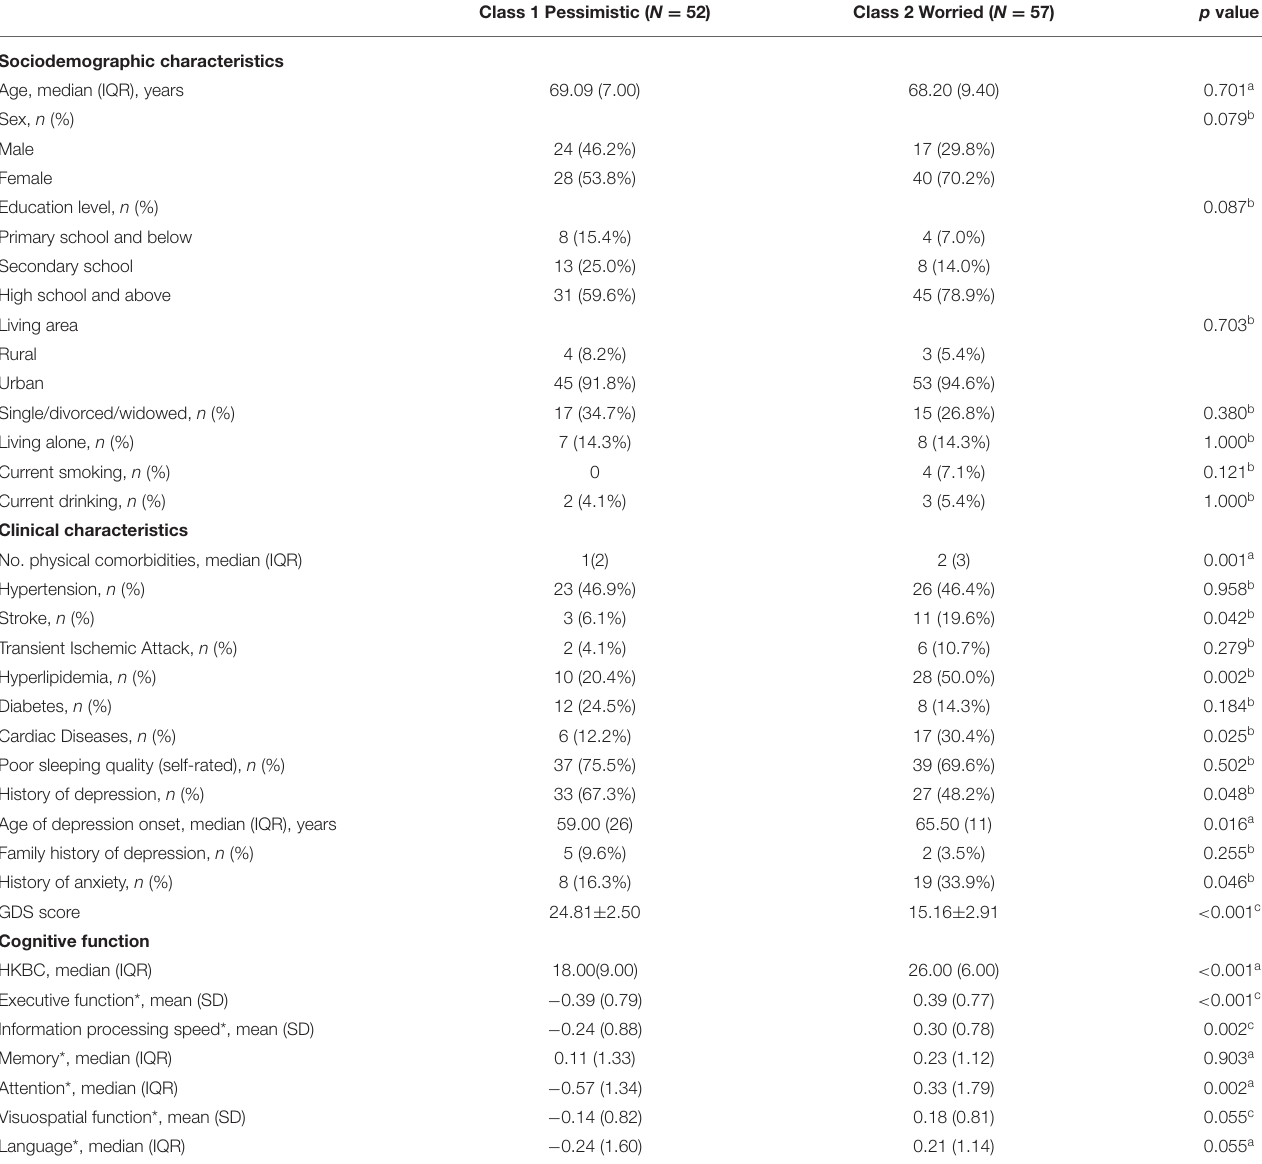
TABLE 2 | Comparison of sociodemographic and clinical characteristics as well as cognitive function between latent